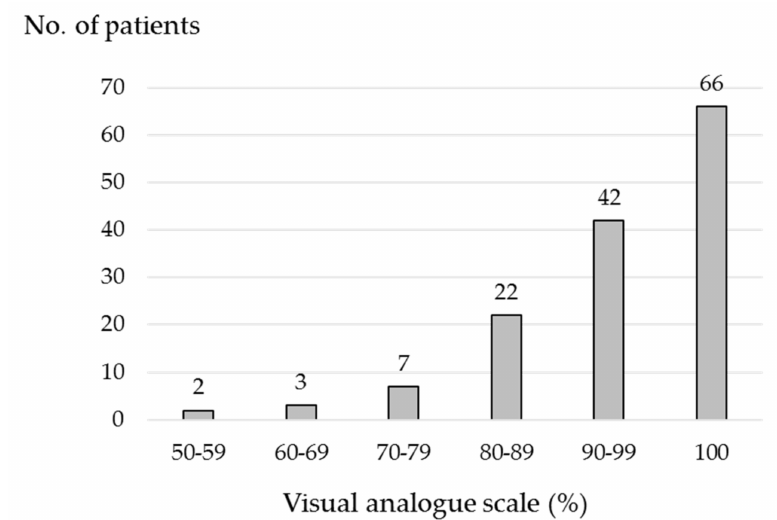
Figure 1. Histogram of the number of patients stratified by 10% of the VAS. VAS, visual analogue scale.